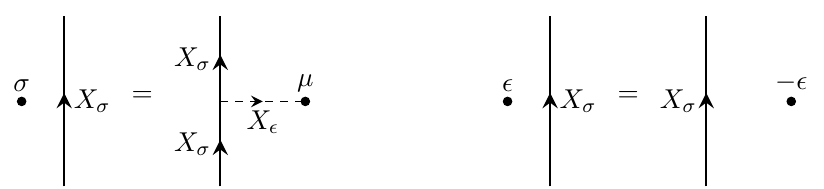
Figure 3 . Left, the X σ defect sweeps past a σ primary, turning it into the disorder operator µ , plus a topological Z 2 tail. Such a µ is traditionally called a “twist-field.” Right, the X σ defect sweeps past the relevant operator (cid:15) and turns it into − (cid:15)